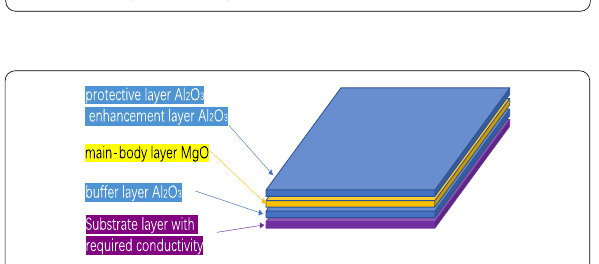
Fig.13 Schematic diagram of sandwich structure (Al 2 O 3 /MgO/Al 2 O 3 )